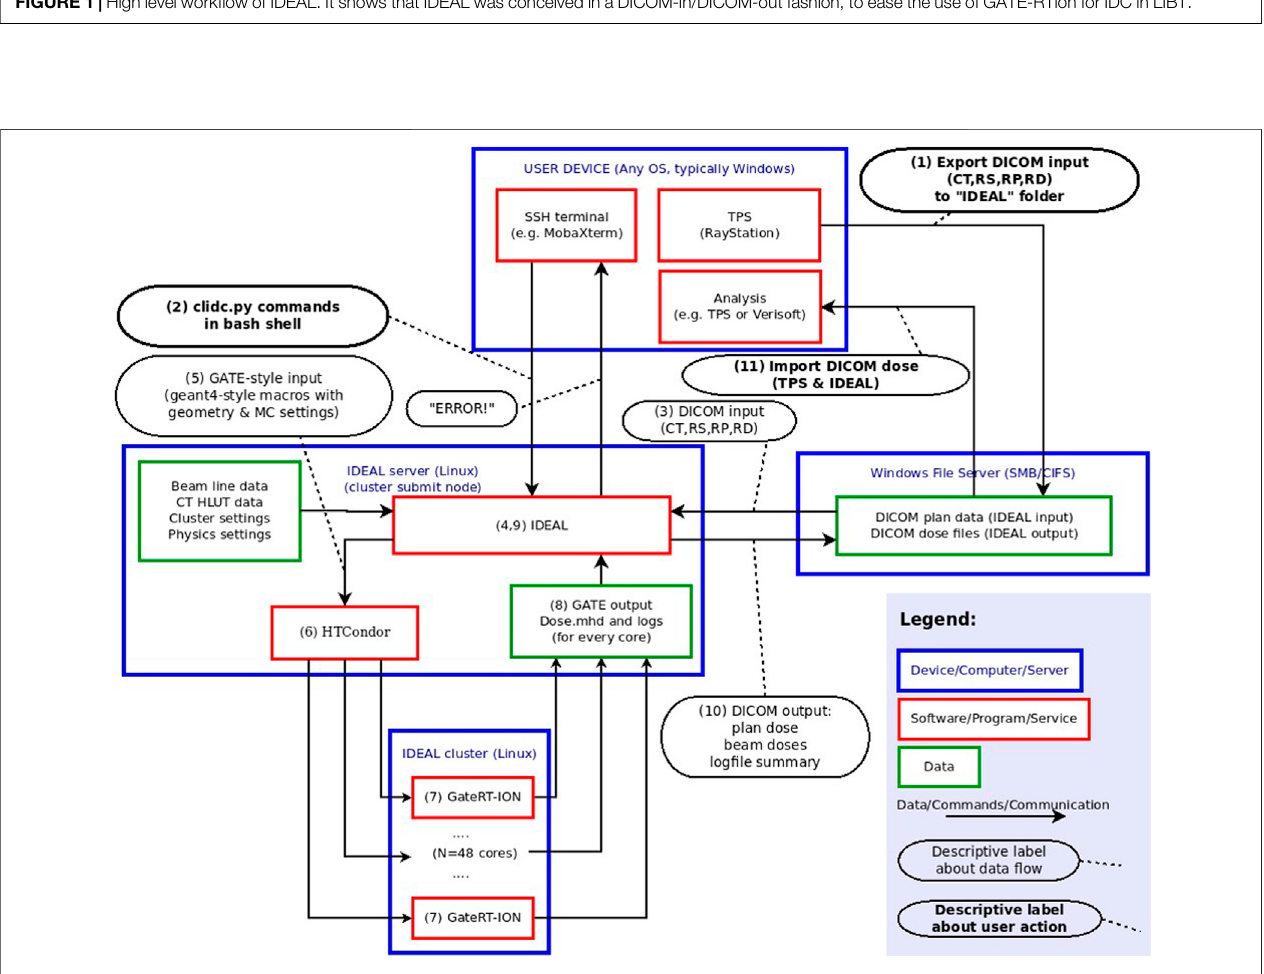
FIGURE2| Device-orientedwork fl owofIDEAL.This fi guredescribesfromatechnicalview-pointthedifferentmodulesimplementedintheIDEALsoftwaretoallow for GATE-RTion-based IDC in LIBT. The numbers in parentheses are used in the text to describe the work fl ow in more detail.